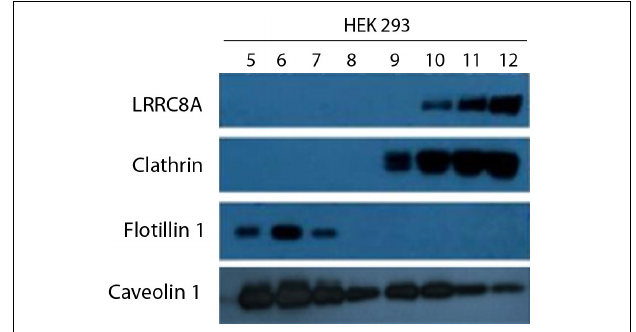
FIGURE 2 | LRRC8A targeting to non-lipid raft domains in a caveolin-dependent manner. A representative experiment of a lipid raft isolation in HEK 293 cells. Twelve fractions from a sucrose-density gradient from total lysates were separated by SDS-PAGE and then immunoblotted with LRRC8A, Cav1, flotillin-1, or clathrin antibodies. Clathrin and flotillin-1 were used as a non-lipid raft and lipid raft markers, respectively. Notice that LRRC8A protein targeted Cav1 in non-floating fractions but not in floating fractions (enriched in lipid raft). Experiments were done in